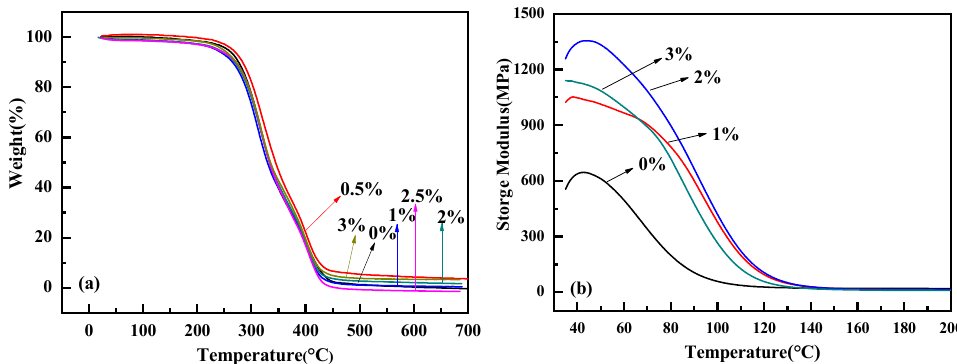
Figure 5. TG curves ( a ) and storage moduli UV ( b ) of the polyurethane–europium materials with different mass contents of europium complex.